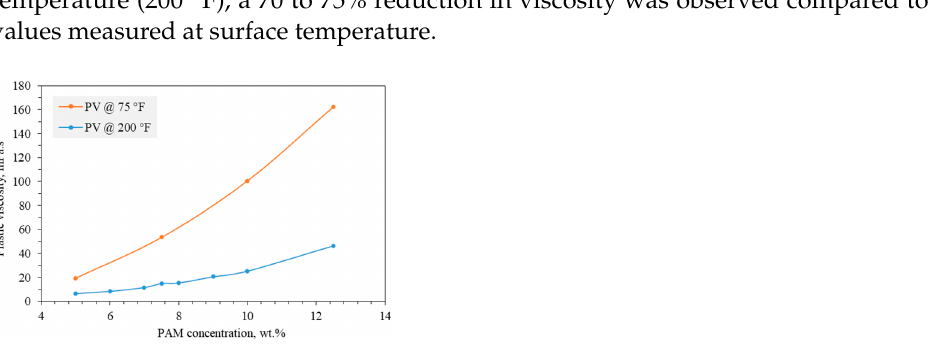
Commented [M1]: Please add space between numbers and symbols.